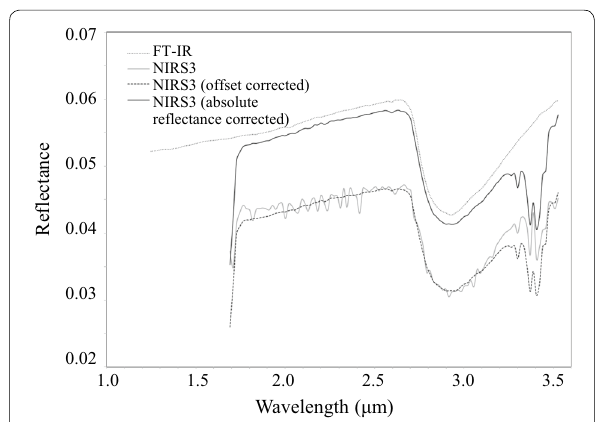
Fig. 5 Data correction process of reflectance spectrum of Y-86720 meteorite. NIRS3 reflectance data were corrected for the systematic offsets of pixel signals ( broken line ) and further corrected using the fitting parameters calculated from the signal intensity of pixel 29 (Fig. 3). The corrected spectrum ( thick solid line ) is very similar to the FT-IR spectrum ( thin solid line